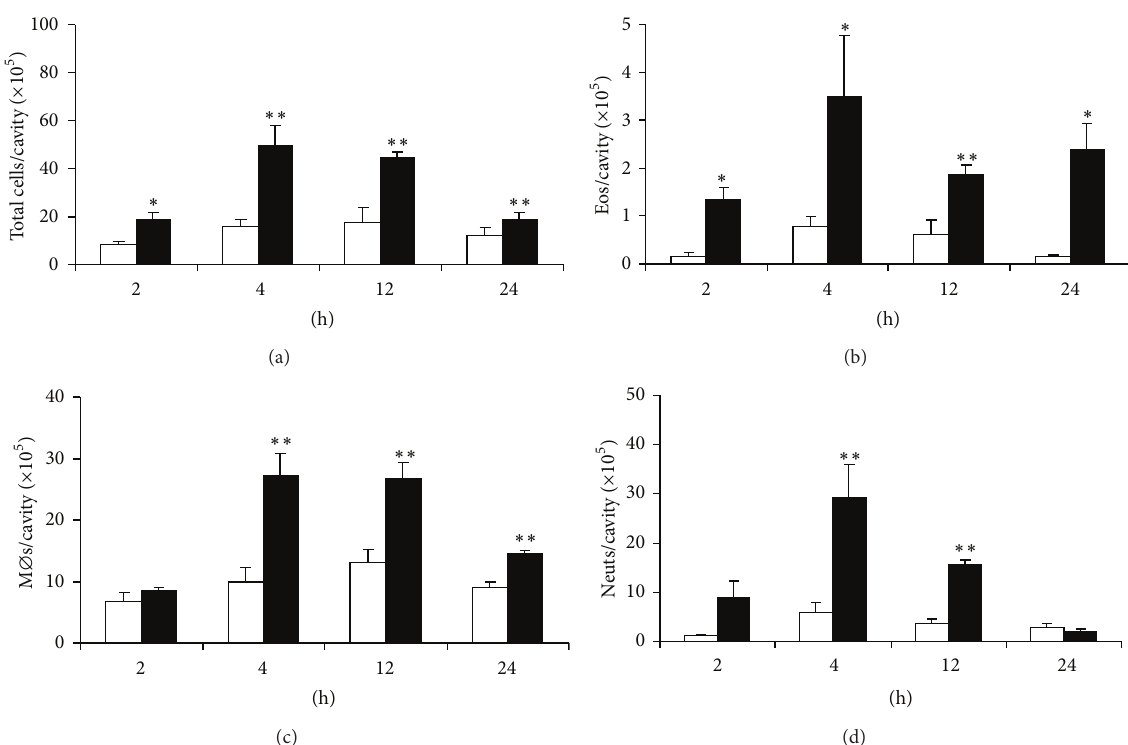
Figure 3: Accumulation of different leukocyte subtypes induced by eotaxin: kinetics. BALB/c mice were injected with 50 ng eotaxin i.p. (black bars), and the peritoneal lavage fluid collected after the indicated periods was used for quantitation of total leukocytes (a), eosinophils (b), macrophages (c), and neutrophils (d). Data are mean ± SEM. ∗ , 𝑃 ≤ 0,05 ; ∗∗ , 𝑃 ≤ 0,01 , for the differences relative to the respective negative (RPMI) controls (open bars). Data from 3–11